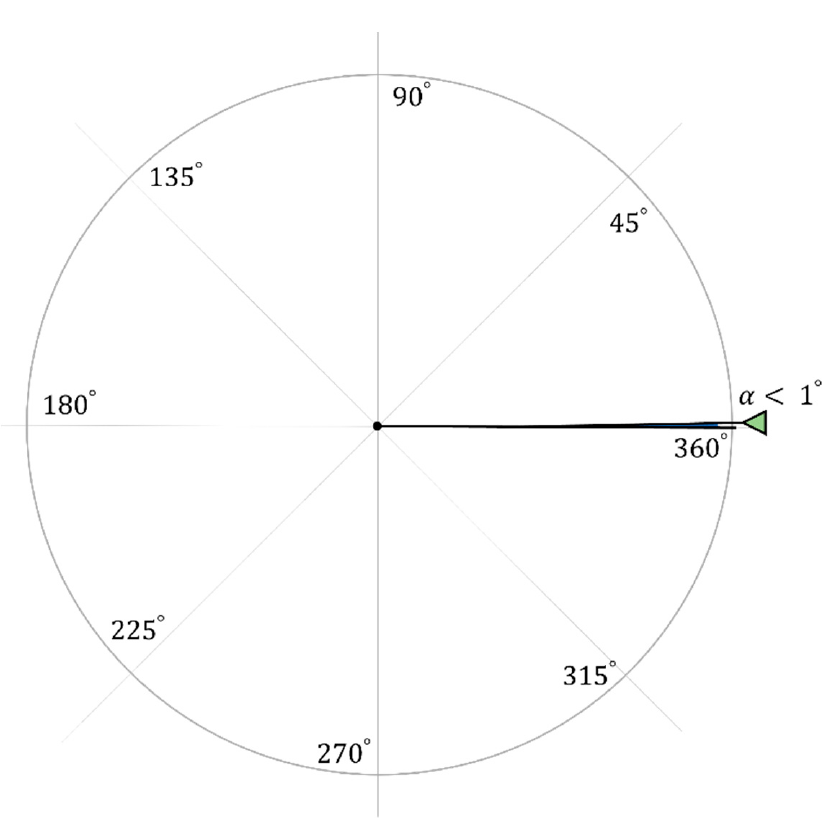
Figure 3. The sector angle of SCAP. As we targeted autonomous channel allocation, each node must be able to identify the sector to which it belongs without any communication with the base station. To achieve this, we supposed that each node knows its coordinates as well as those of the base station. Three steps are then followed by the IoT device to determine its sector identifier and hence that of its